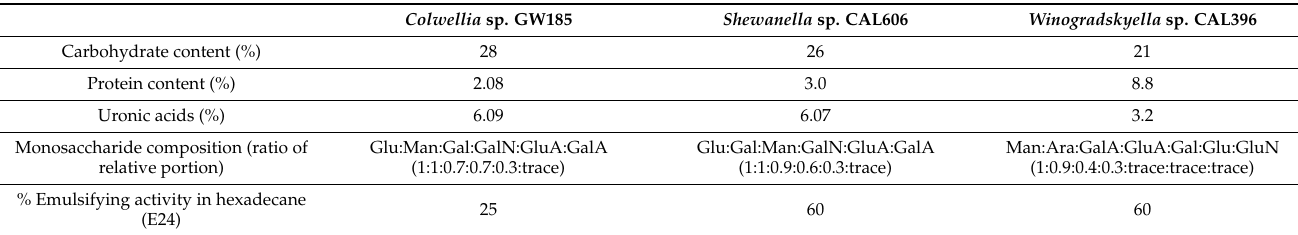
Table 5. Characteristics of exopolymers from Colwellia sp. GW185, Shewanella sp. CAL606 and Winogradskyella CAL396 associated with Antarctic sponges (data from Caruso et al. [26]).